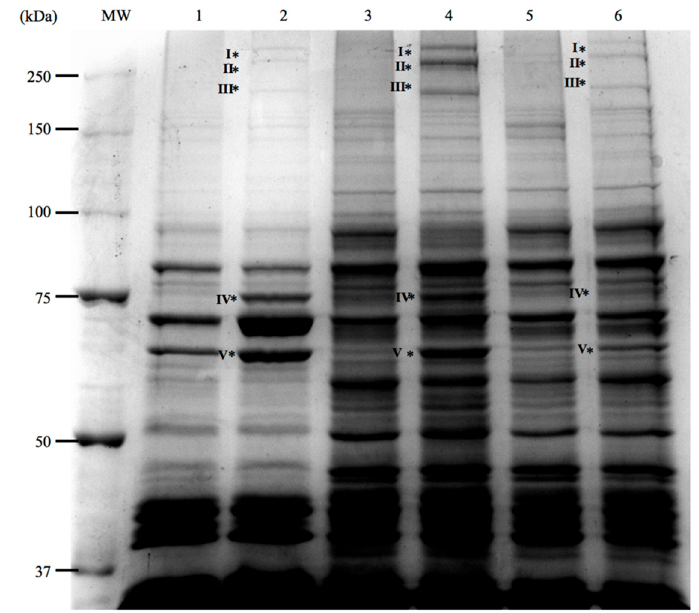
Figure 5. Representative SDS-PAGE gel showing outer membrane protein (OMP) profiles of V. ordalii strains under iron-rich and iron-limited conditions. MW: Molecular weight marker; 1: ATCC 33509 T under iron-excess conditions; 2: ATCC 33509 T under iron-limitation (TSB-1 + 2,2 ′ -dipyridyl 45 µM); 3: Vo-LM-13 under iron-excess, 4: Vo-LM-13 under iron-limitation (TSB-1 + 2,2 ′ -dipyridyl 90 µM); 5: Vo-LM-18 under iron-excess; and 6: Vo-LM-18 under iron-limitation (TSB-1 + 2,2 ′ -dipyridyl 60 µM). *: Proteins expressed only under iron limitation and identified by PMF as follows: I, VabF (vanchrobactin synthesis); II, Irp1; III, Irp2 (piscibactin synthesis); IV, HuvS (heme receptor); V, FrpA (piscibactin Table 2. Identification by peptide mass fingerprinting (PMF) of five proteins differentially expressed under iron limitation in SDS-PAGE gel showed in Figure 5.